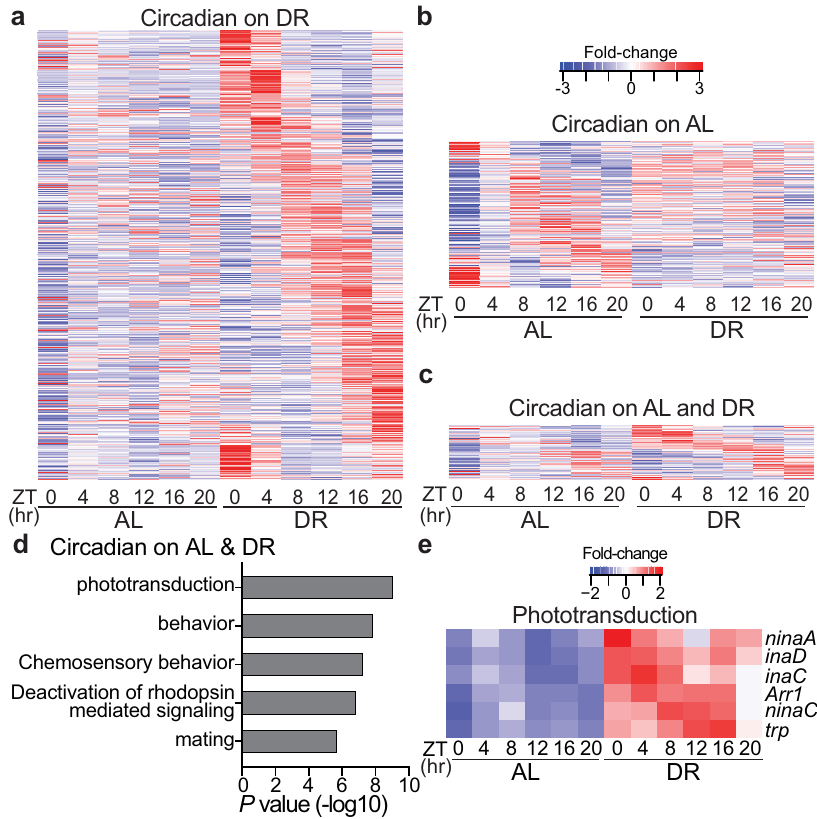
Fig. 1 Dietary restriction ampli fi es circadian transcriptional output and rhythmicity of phototransduction genes. a – c Circadian transcriptome heatmaps for Canton-S fl ies representing 24 h expression plots for transcripts that cycle only on DR ( a , n = 1487 transcripts), only on AL ( b , n = 548 transcripts), or on both diets ( c , n = 259 transcripts). Circadian transcripts plotted here are de fi ned as having JTK_CYCLE P ≤ 0.05 (non-adjusted, non-rhythmic [ P ≥ 0.05] in tim01 mutants) and are plotted by phase. d Gene-ontology enrichment categories corresponding to transcripts that cycle on both AL and DR diets. P- values were calculated with hypergeometric distribution ( fi ndGO.pl, HOMER) with no adjustment for multiple-hypothesis testing. e Heatmap of phototransduction transcript expression on AL and